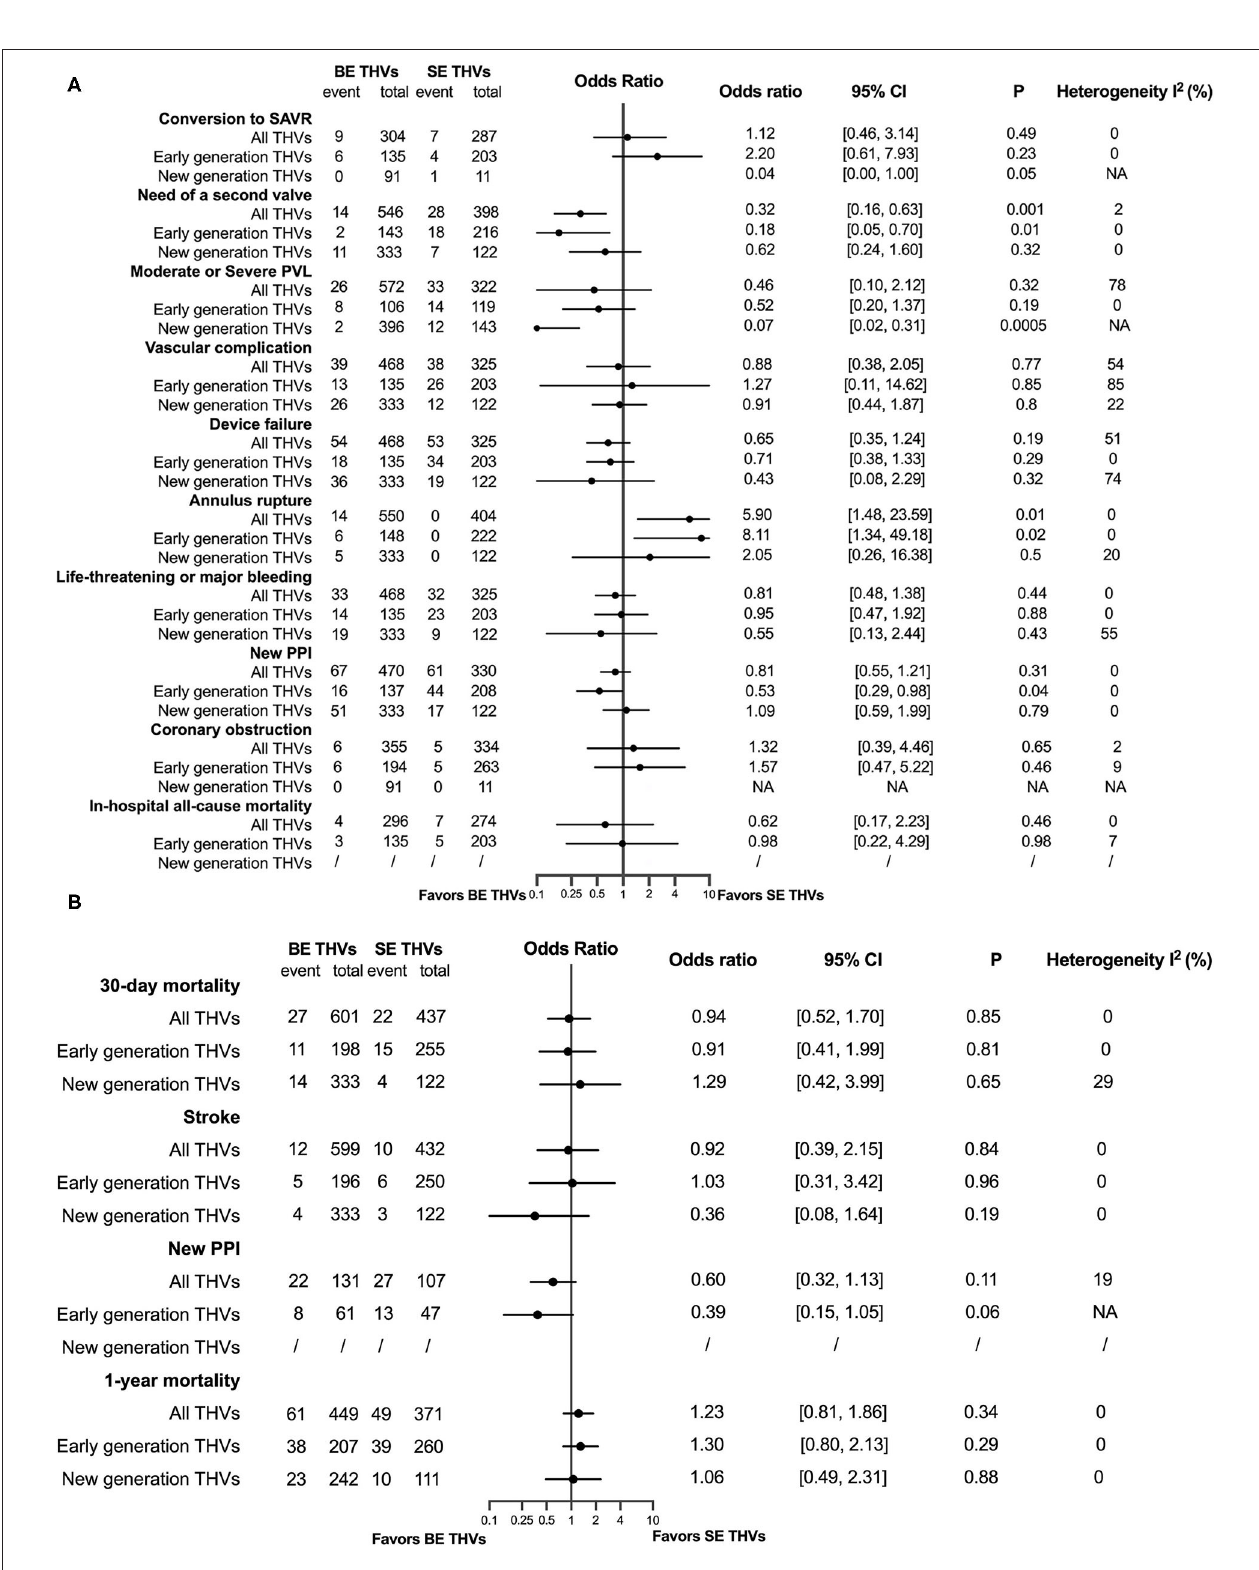
FIGURE 5 | A comparison between balloon-expandable (BE) and self-expanding (SE) valves in patients with BAV at in-hospital time (A) , and in a 30-day and a 1-year (B) follow-up. SAVR, surgical aortic valve replacement; PVL, paravalvular leakage; PPI, permanent pacemaker implantation.